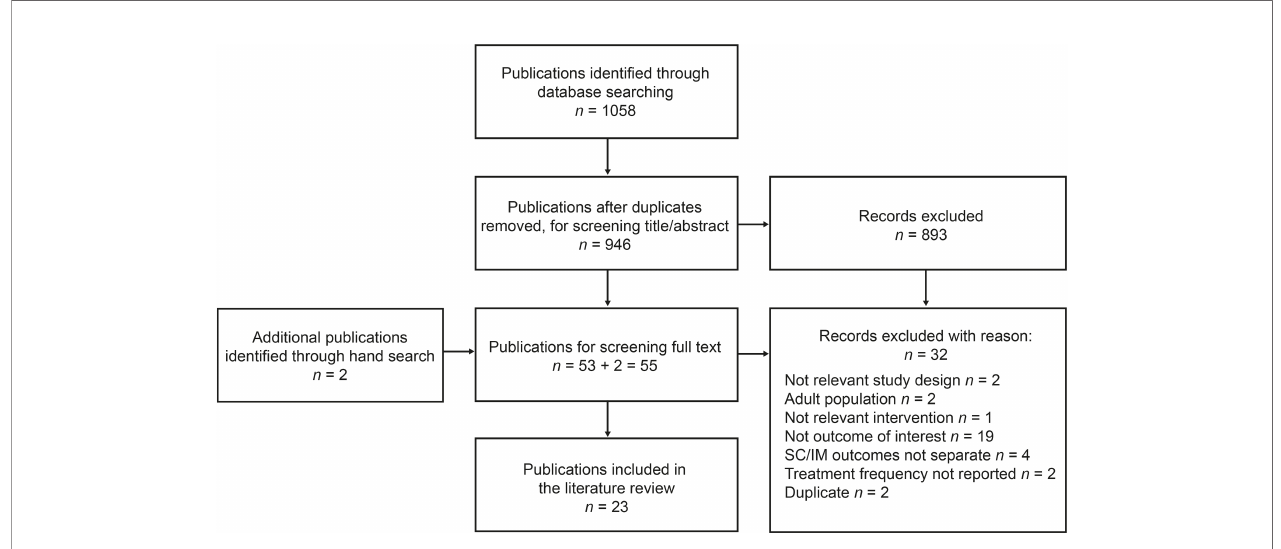
FIGURE 1 | PRISMA diagram of the literature-screening process. PRISMA, Preferred Reporting Items for Systematic Reviews and